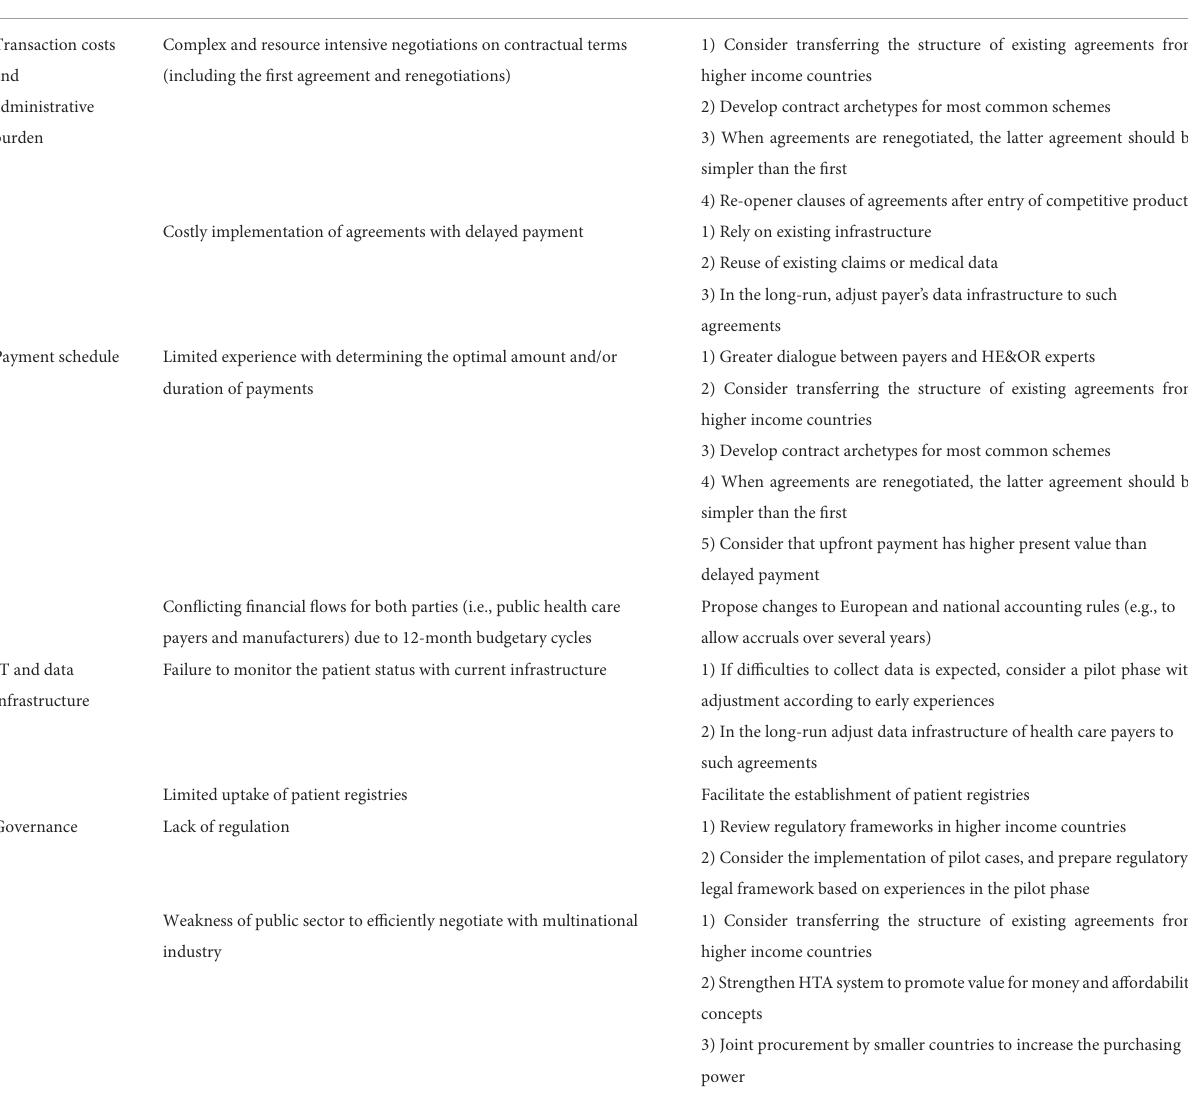
Group of barriers